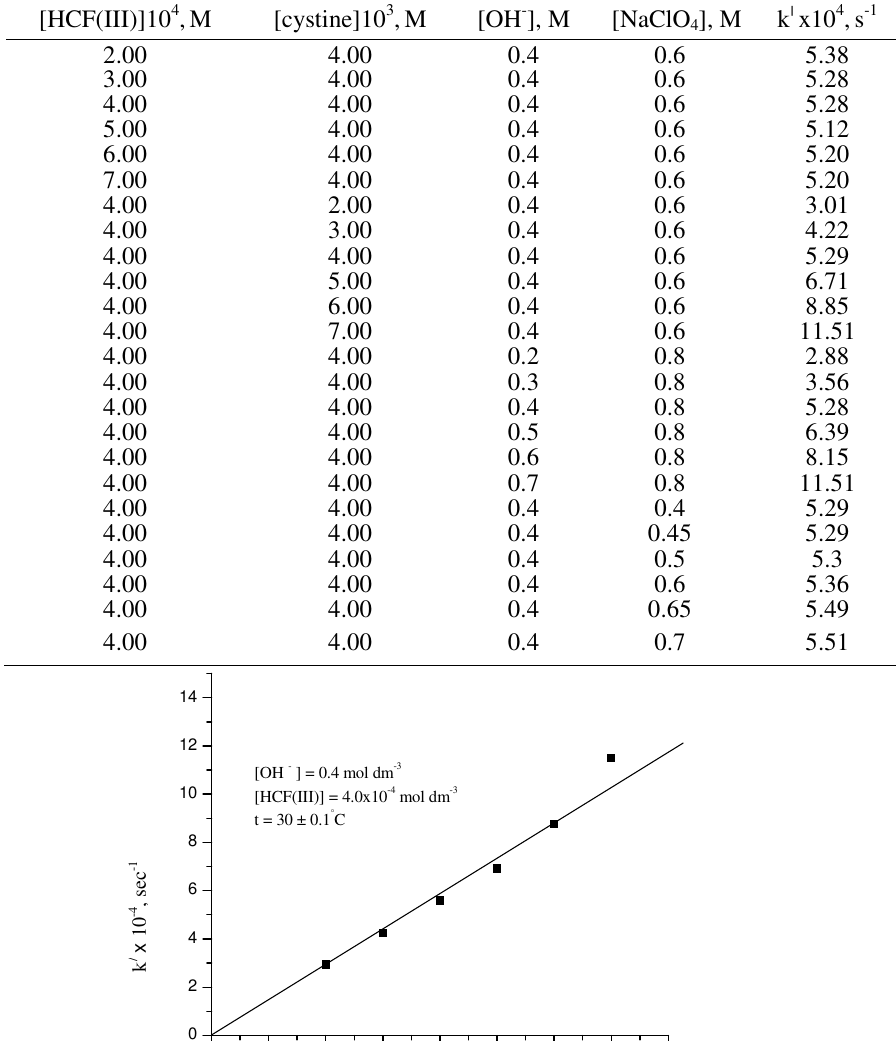
Table 1. Effect of varying concentrations of [HCF(III)], [cystine], [OH - ] and [NaClO the pseudo first order rate constant, k (cid:3) at 30±0.1 0 C